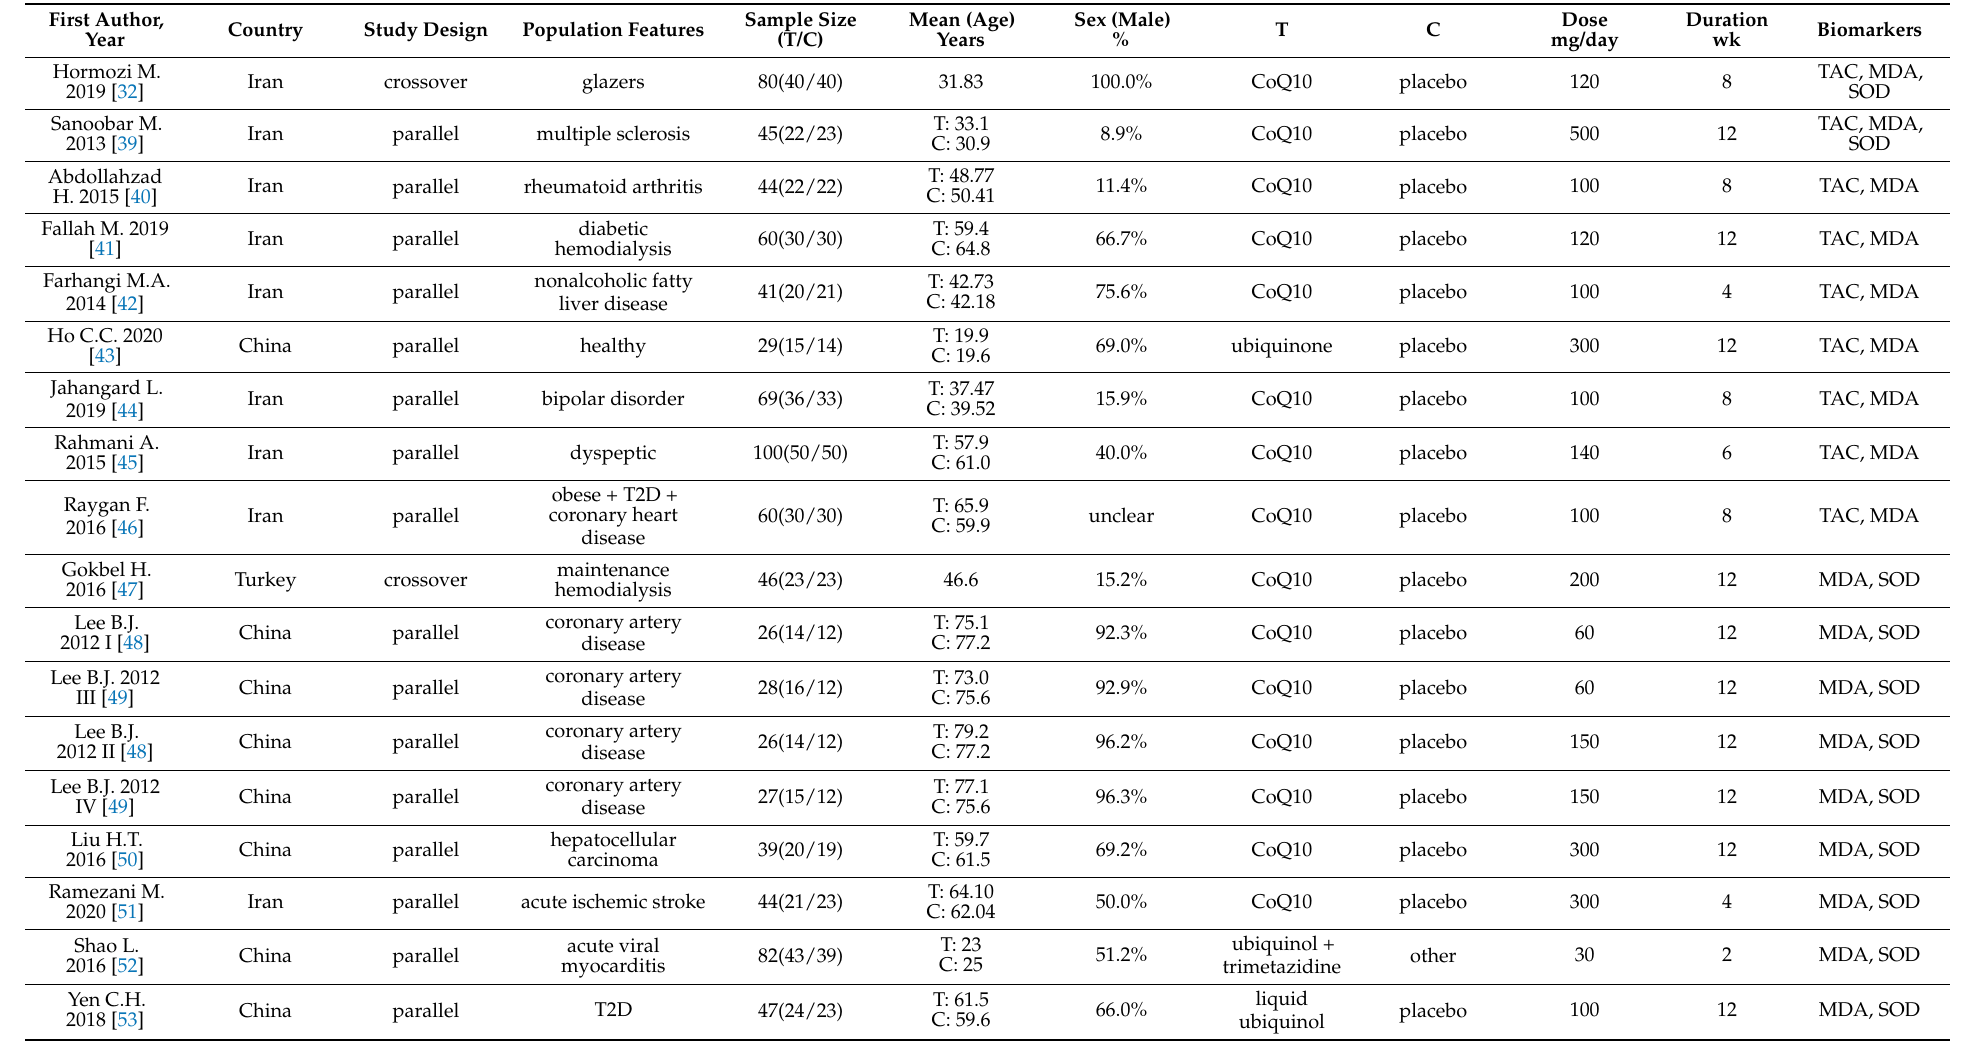
Table 1. Characteristics of included RCTs to investigate the effects of CoQ10 on oxidative stress